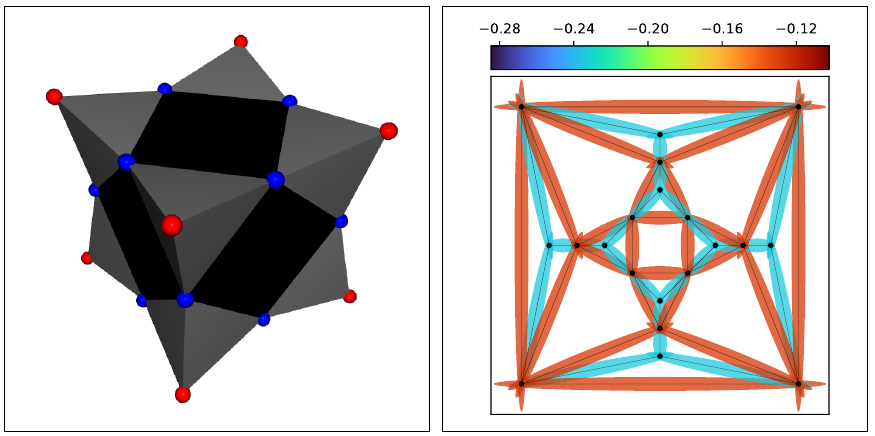
Figure 4: Left: Ball-and-stick drawing of the hypothetical SOD20 molecule (a cuboc- tahedron where each triangle face is decorated (capped) with an additional apex spin site). The sites that are distinct by symmetry are coloured red (apex) and blue (base). Right: Nearest-neighbour spin-spin correlations on this geometry. The two distinct values that appear are: − 0.2346 (red-blue) and − 0.1274 (blue-blue). The ground state is unique with no broken symmetries. The results were obtained using exact